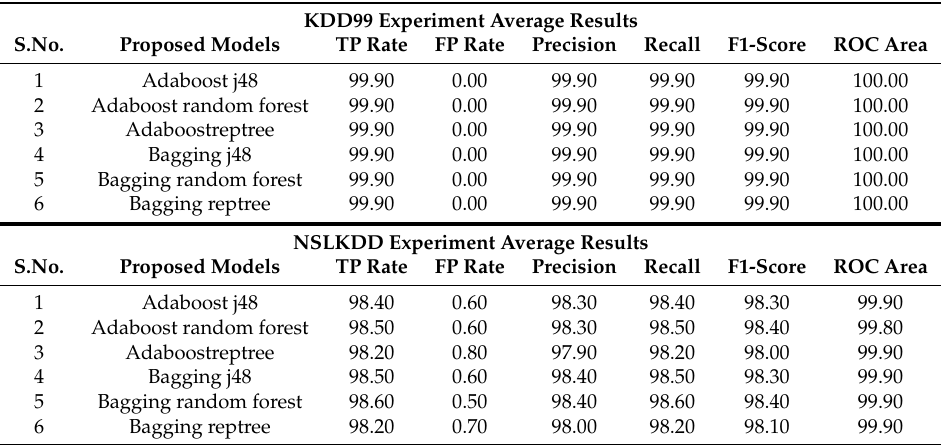
Table 46. Comparison of proposed models for binary class classification. KDD99 Experiment Average Results S.No.